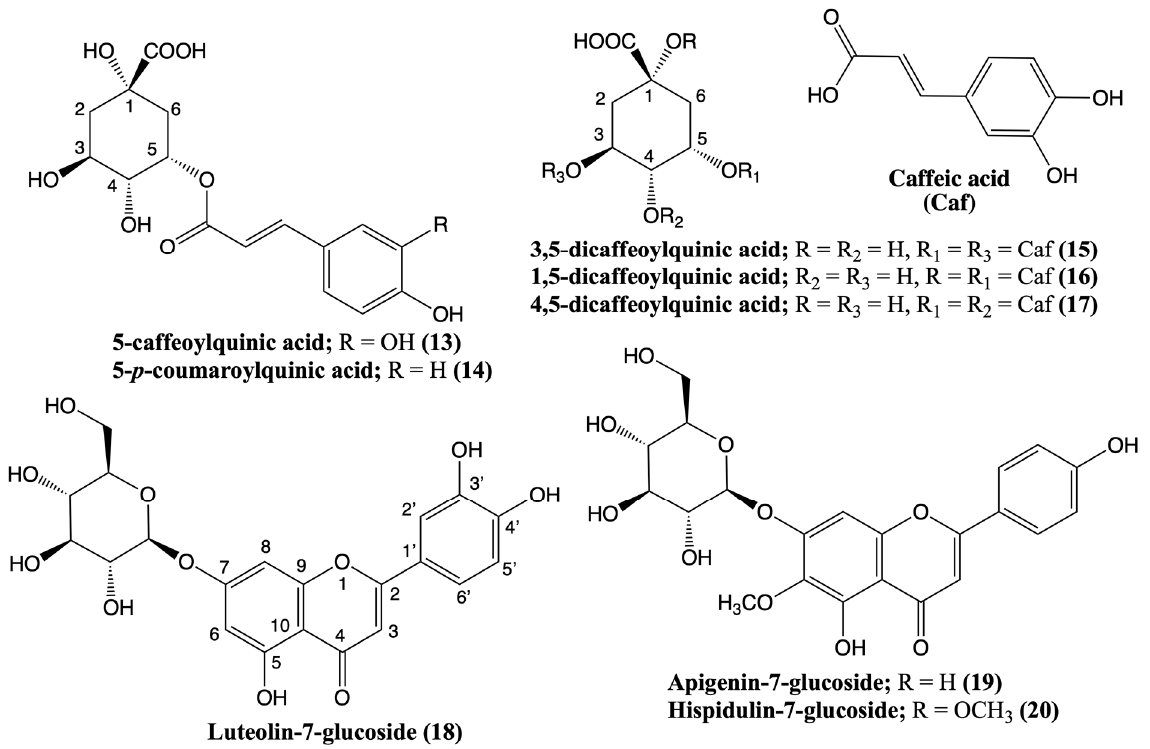
Figure 5. Structures of the antioxidant phenolic compounds of the fruit and root methanolic extracts of Ferula drudeana .